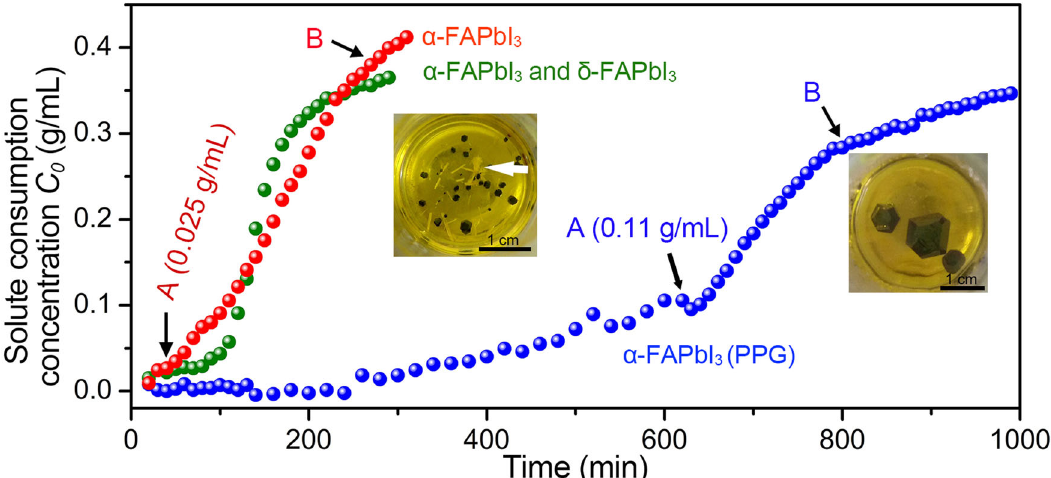
Fig. 5 The crystallization kinetics analysis of FAPbI 3 single crystals. a The solute consumption as a function of the growth time at 90 °C. The FAPbI 3 / GBL solution ( C FAPbI3 = 0.75 g/mL): (1) only black crystals grow (red) or (2) yellow crystals also appear (green); The FAPbI 3 /(GBL + PPG) solution ( C FAPbI3 = 0.75 g/ mL, C PPG = 0.05 g/mL) that only black crystals (blue) grow. The yellow needle-like crystals, marked by the white arrow in the photo, are δ -FAPbI 3